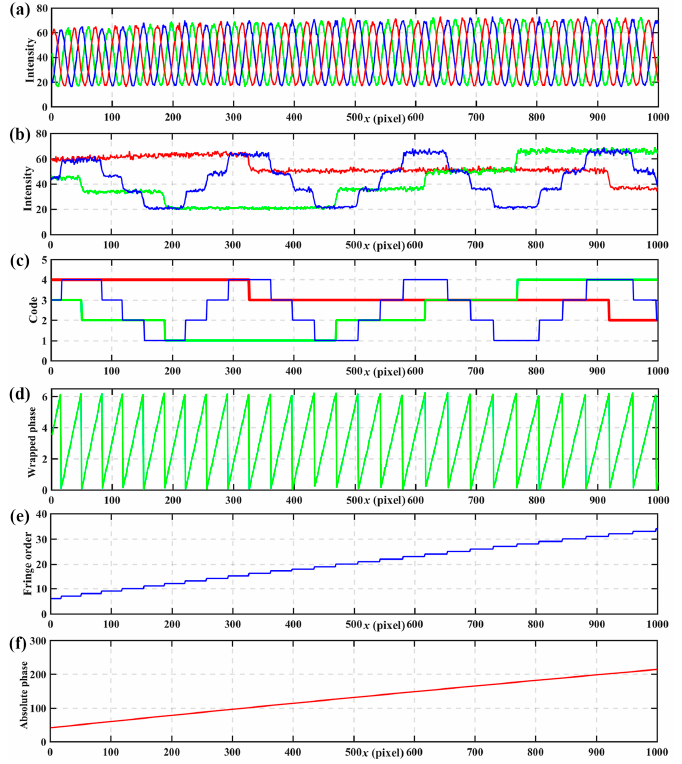
Figure 10. One cross-section of the reference plane. ( a ) phase-shift patterns, ( b ) n GC patterns, ( c ) calculated codewords, ( d ) wrapped phase, ( e ) determined fringe order, and ( f ) absolute phase.